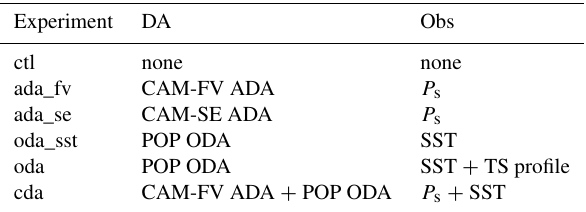
Table 1. List of experiments.